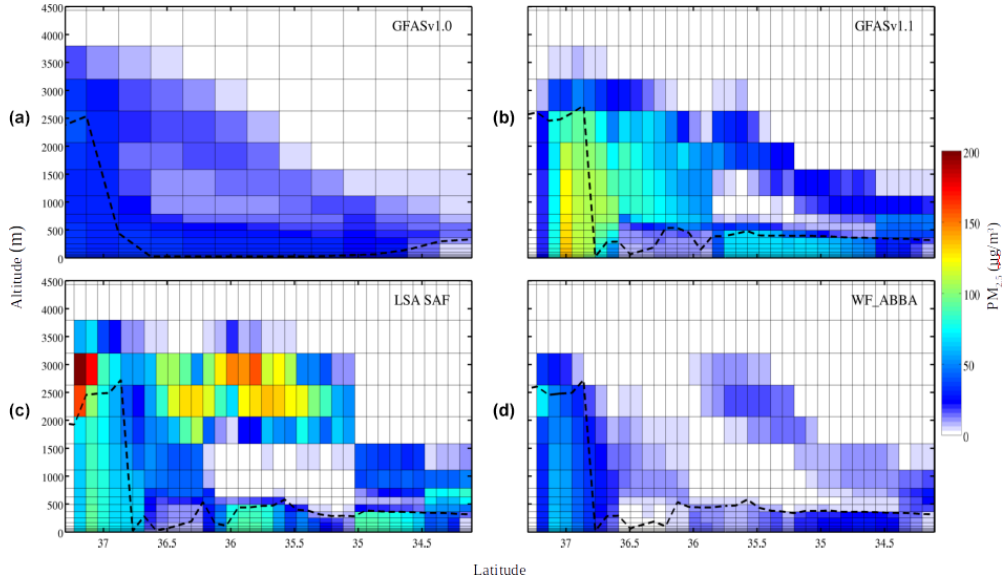
Figure 7. On 1 August 2008 at 15:00LT, vertical cross section, across the concurrent maximum-simulated AOT, showing the changes in the PM 2 . 5 concentration across the main plume of Antalya fire for the CMAQ simulations performed with GFAS1.0 (a) , GFAS1.1 (b) , LSA SAF (c) and WF_ABBA-based (d) fire emission inventories. The changes in the PM 2 . 5 concentration are calculated by subtracting concentrations from simulations without fires. The black-dashed line defines the